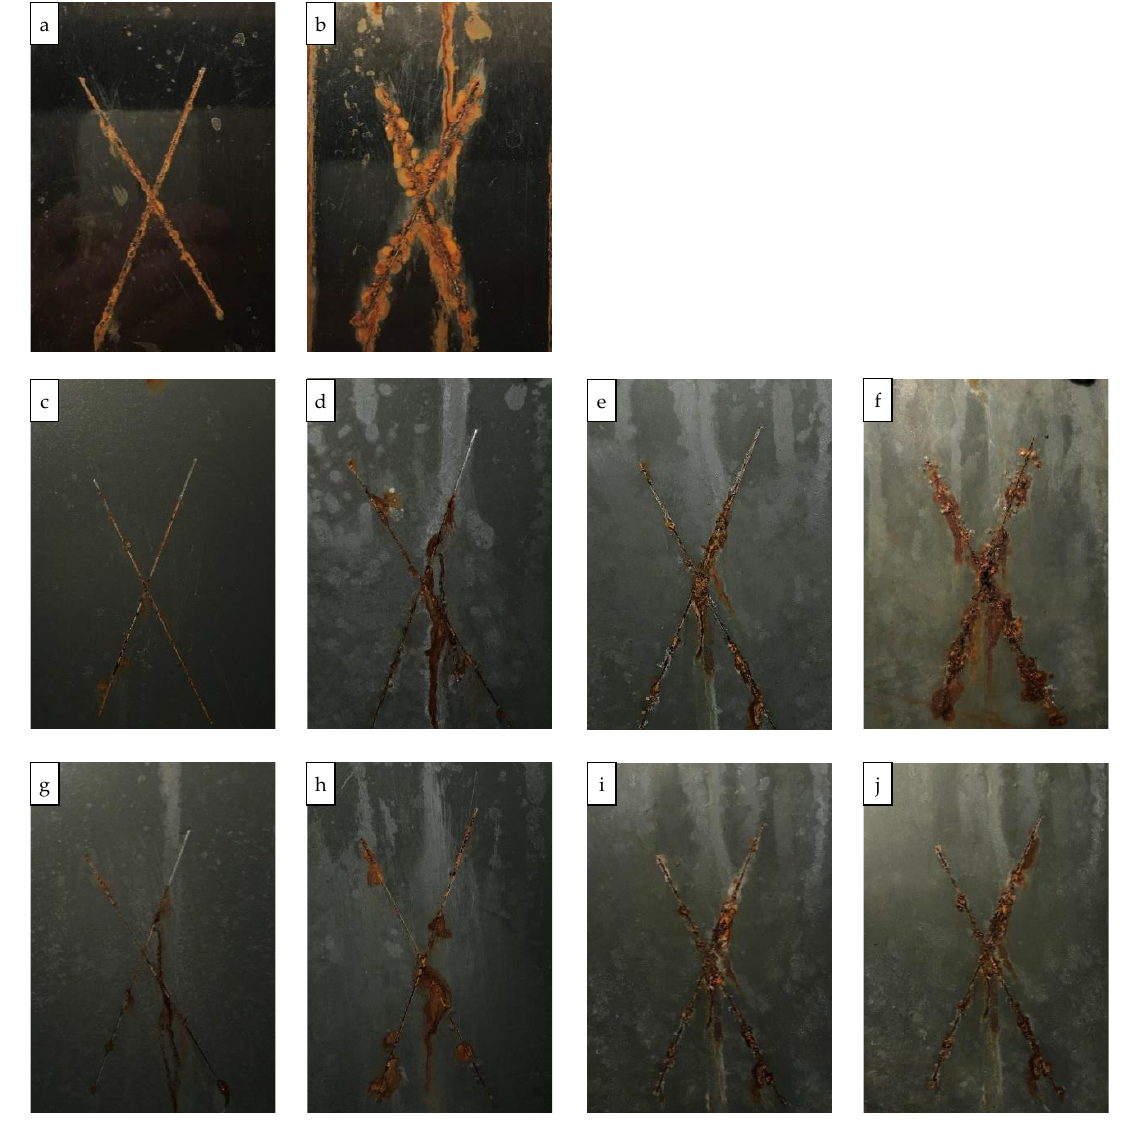
Figure 11. Test panels prepared from the coatings with 0, 60 and 80% zinc after the neutral salt spray test. ( a , b ) PC-Control, 500–1000 h; ( c – f ) zinc 60%, 500–2500 h; ( g – j ) zinc 80%, 500–3000 h. ( a ) Control-PC 500 h; ( b ) Control-PC 1000 h; ( c ) Zn–60%-PC 500 h; ( d ) Zn–60%-PC 1000 h; ( e )Zn–60%-PC 1500 h; ( f ) Zn–60%-PC 2500 h; ( g ) Zn–80%-PC 500 h; ( h ) Zn–80%-PC 1000 h; ( i ) Zn–80%-PC 2000 h; ( j ) Zn–80%-PC 3000 h.